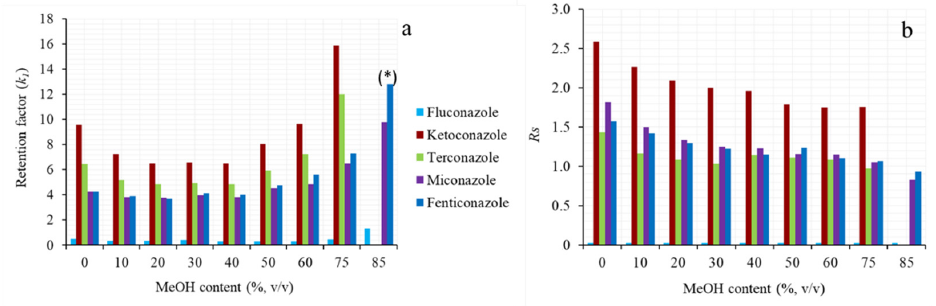
Figure 2. Effect of MeOH (in ACN/MeOH ratio) content on ( a ) k 1 and ( b ) enantioresolution of some selected azole antifungal drugs. Chromatographic conditions: 20 mM ammonium hydrogen carbonate (pH 9) in organic phase/water (85/15, v / v ). * >90 min analysis time for